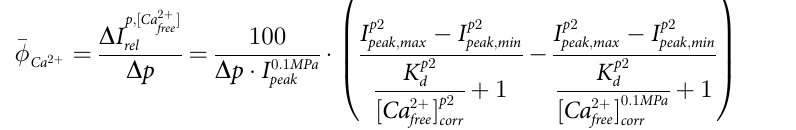
¼ (cid:0) 0 : 023 % MPa -1 . Ca 2 þ